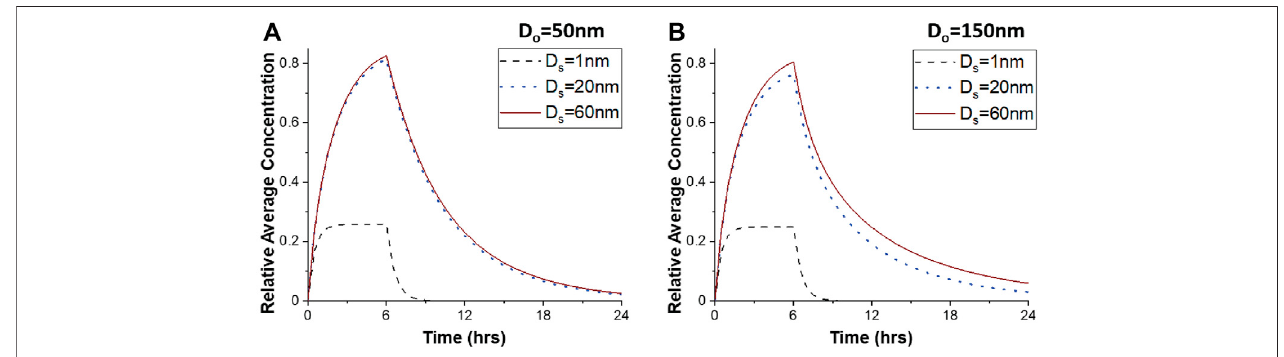
FIGURE 6 | Average drug concentration as a function of the time for different vessel wall pore diameters. Average relative drug concentration in tumor tissue as a function of time for different diameters of therapeutic agents, D s , for 2 × 10 − 13 m 2 /(Pa s) hydraulic conductivity of the tumor interstitial space, and for different pore diameters of tumor vascular walls, D o : (A) 50 nm and (B) 150 nm. Drug concentration is normalized by division with the reference value entering the